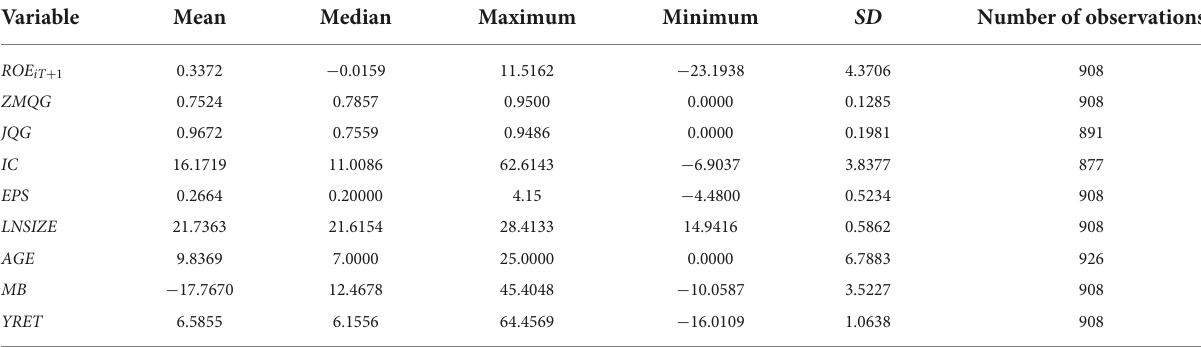
TABLE 4 Descriptive statistics of